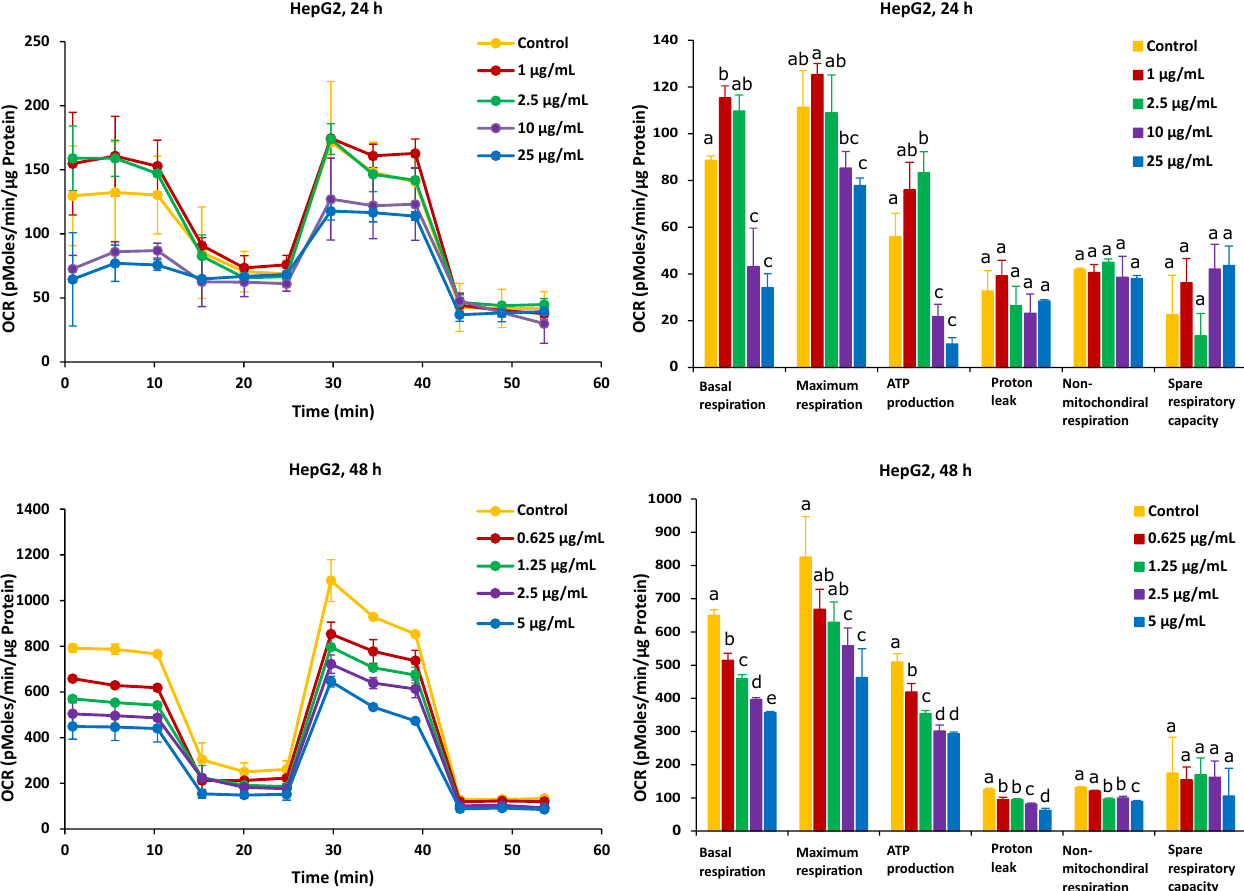
Figure 5. Effect of FB1 on oxygen consumption rate (OCR) ( left ) and different mitochondrial parame- ters ( right ) in HepG2 cells after 24 h and 48 h of exposure. Data (at least four technical replicates) are expressed as mean ± standard deviation. Mean values with different letters (a–e) within each mitochondrial parameter indicate significant differences ( p < 0.05) between different FB1 treatments according to one way ANOVA test followed by Tukey (HSD) multiple-comparison test as a post hoc